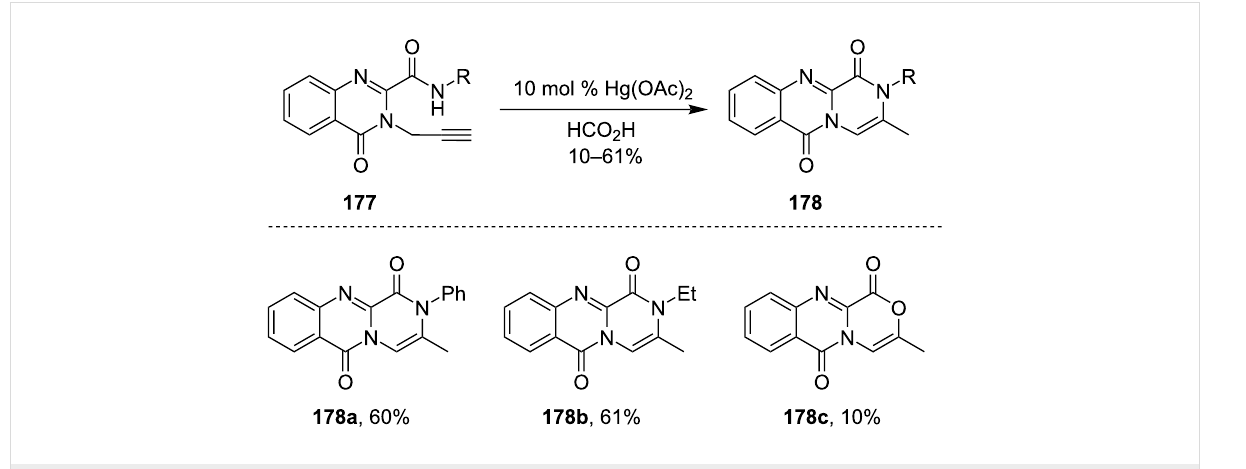
Scheme 53: Synthesis of tricyclic heterocyclic scaffolds.